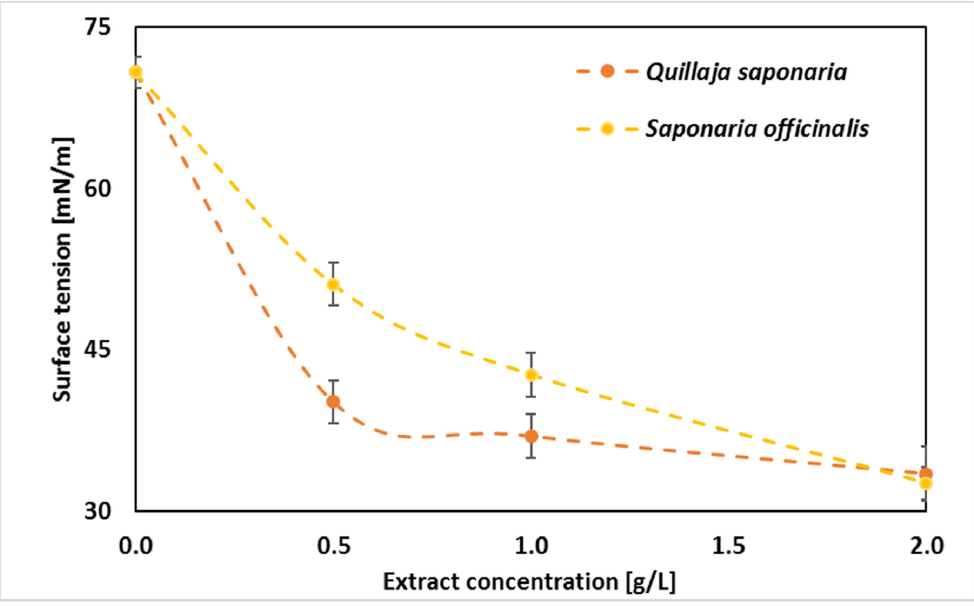
Figure 5. Surface tension versus surfactant concentration (SD presented as error bars).